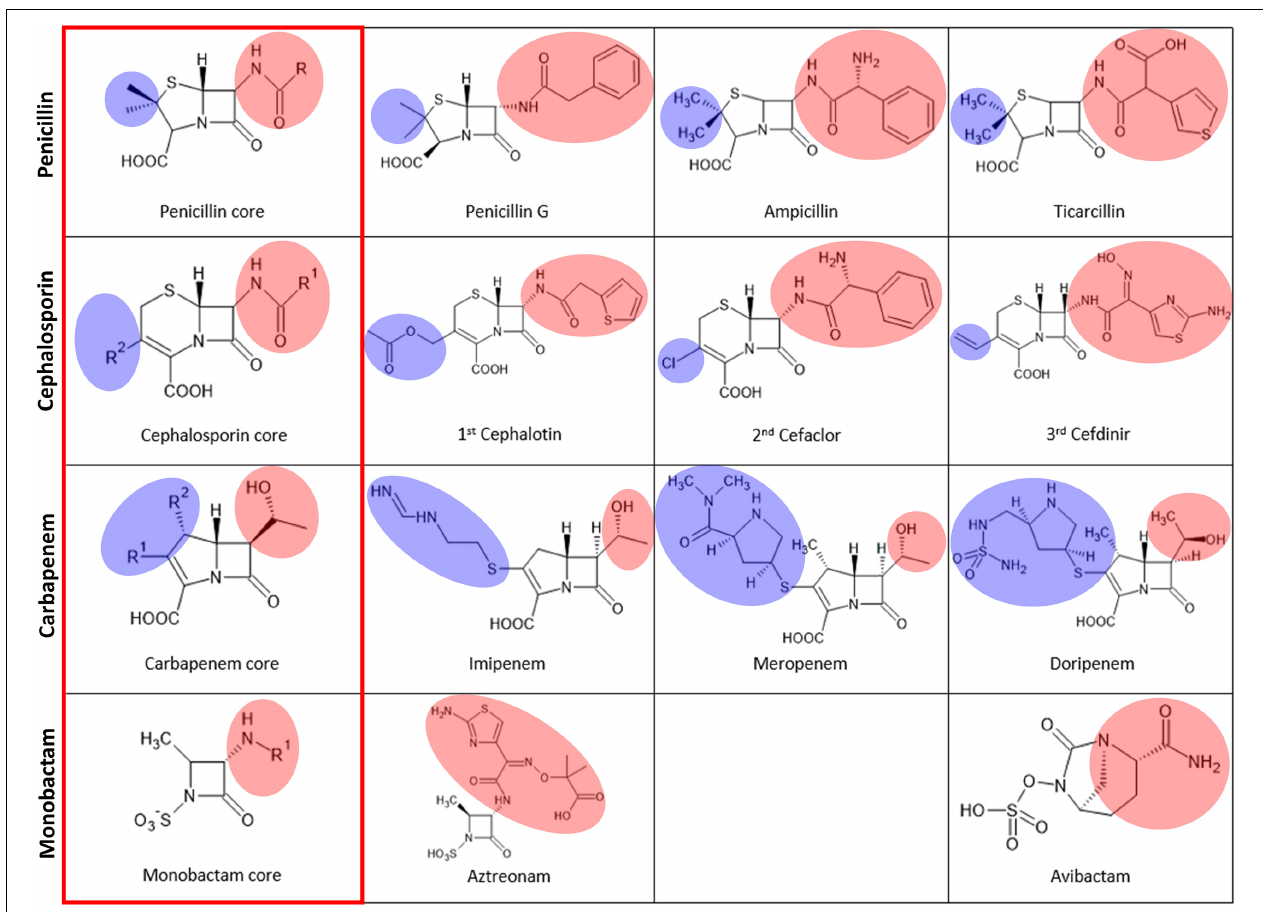
FIGURE 5 | The chemical structures of the four major classes of β -lactams. The left column, labeled with a red rectangle, shows the core scaffold of each type of β -lactam. The substituted R groups at the four-member β -lactam ring are shaded in pink, and those at the five or six-membered dihydropyrrole ring or dihydrothiazine ring next to the β -lactam ring are shaded in